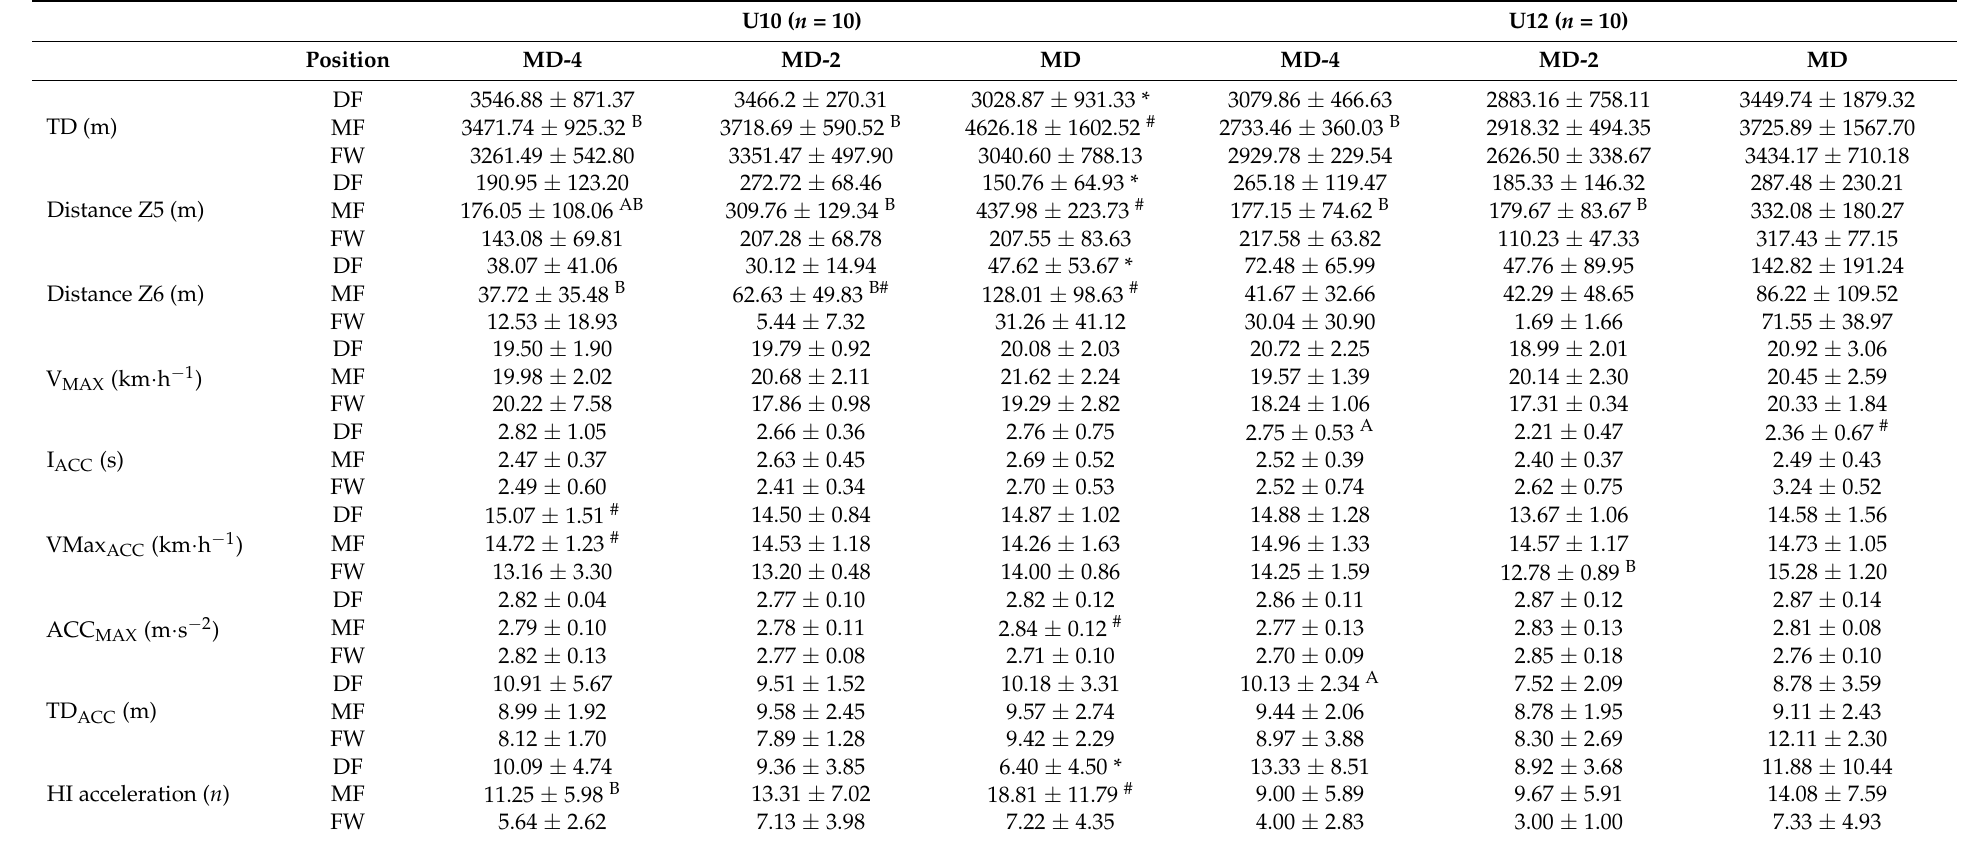
Table 3. Absolute training and match load metrics for U10 and U12 football